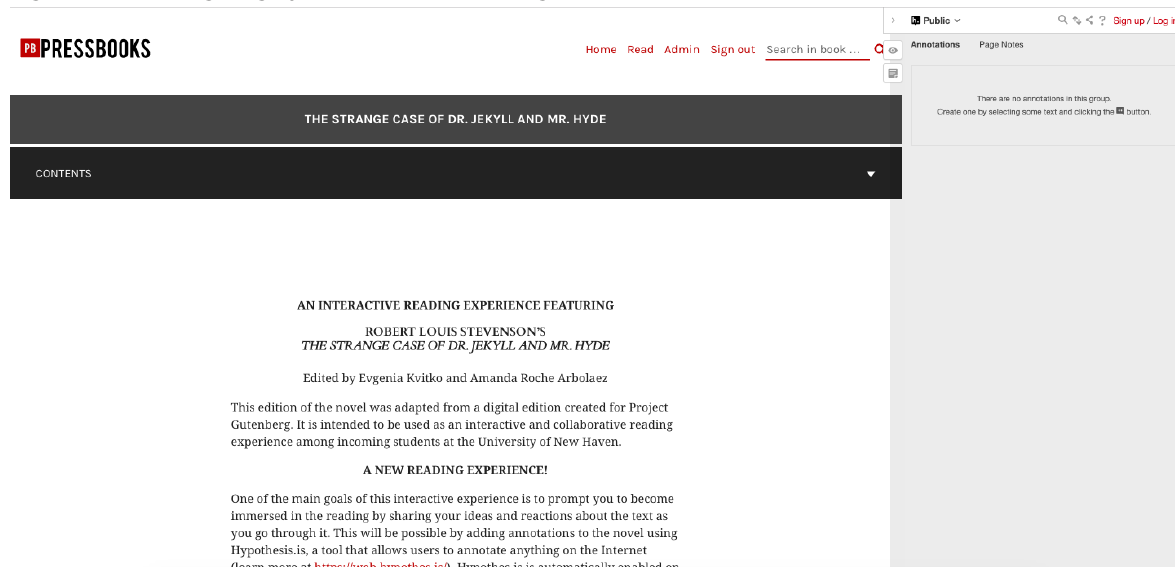
Figure 2. Landing Page for 2017 Honors Program Common Read